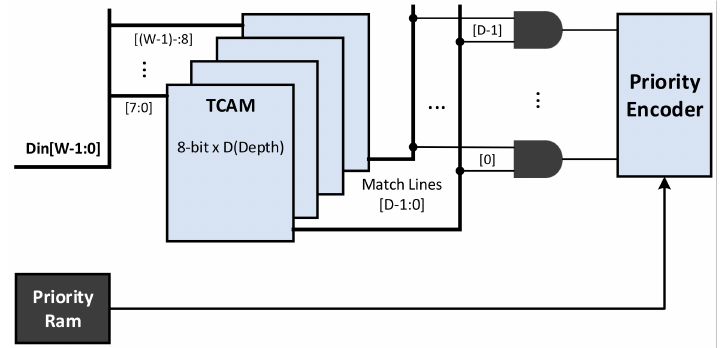
Figure 12. Design overview of our TCAM-based LPM table.